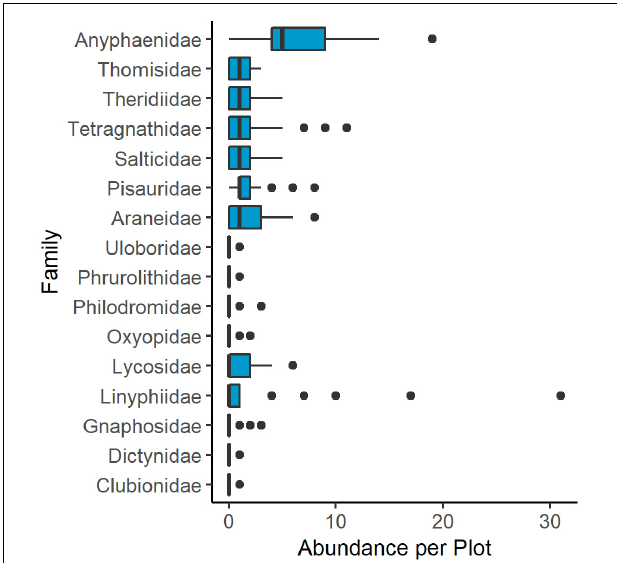
FIGURE 3 | Boxplot showing abundance of spider families collected through both vacuum and leaf litter samples in 2018 throughout all 29 plots in Washington, Frederick, and Montgomery counties, Maryland. Boxes include the 25th and 75th percentile and median values. Whiskers show values up to 1.5 times the interquartile range and outlying points are greater than 1.5 times the interquartile range.